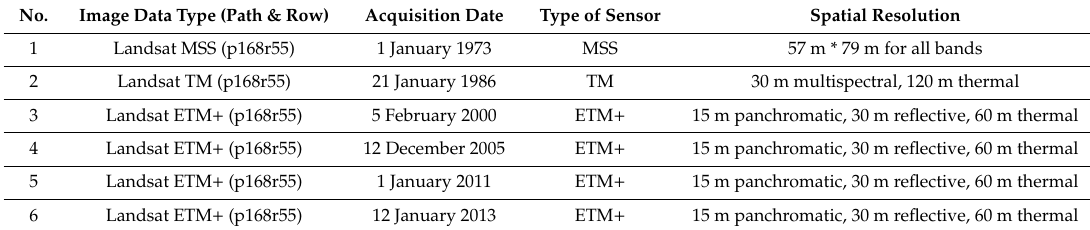
Table 1. Characteristics of the remotely sensed datasets used for land cover analysis in this study. No. Image Data Type (Path &